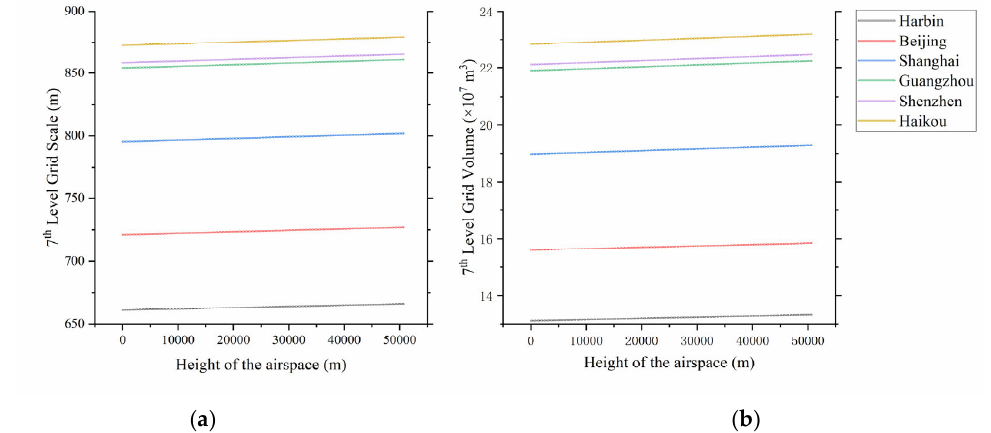
Figure 10. Analysis of shape change law with height: ( a ) grid scale variation; ( b ) capacity variation.